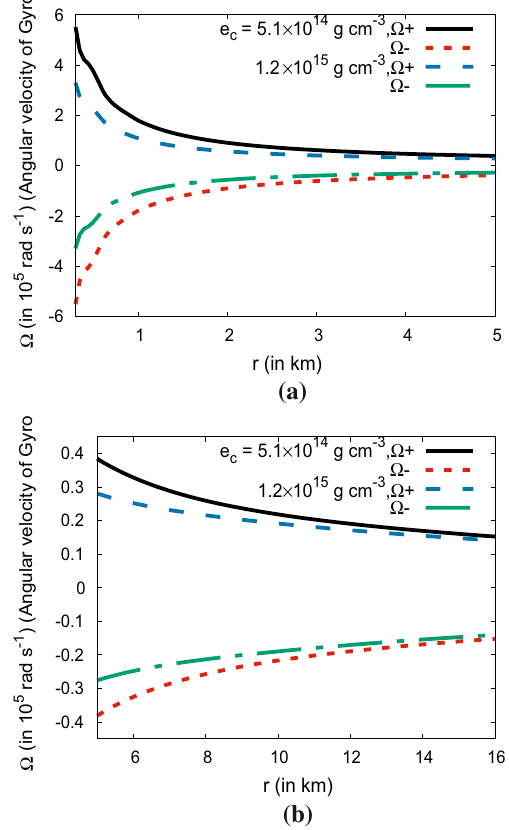
Fig. 7 Plots of the limiting values of the orbital velocity of the gyro with distance from the center of the NS. The black solid curve for prograde motion and red short dashed curve for retrograde motion are for central energy density 5 . 1 × 10 14 gcm − 3 and the blue dashed curve for prograde motion and green dot dashed curve for prograde motion for central energy density of 1 . 2 × 10 15 g cm − 3 . The NS’s rotation rate ( ω ) is taken to be 700 rad s − 1 . a Shows the range close to the centre